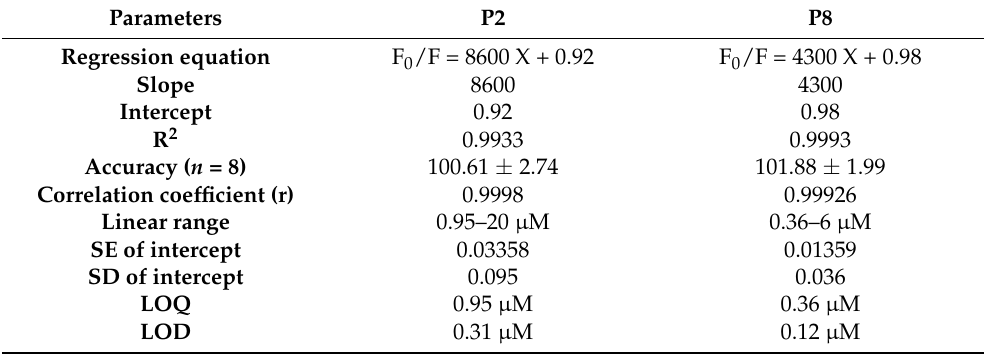
Table 2. The calibration data of the Eu (III)–(vitB1) 2 probe with chlorfenvinphos (P 2 ) and malathion (P8).